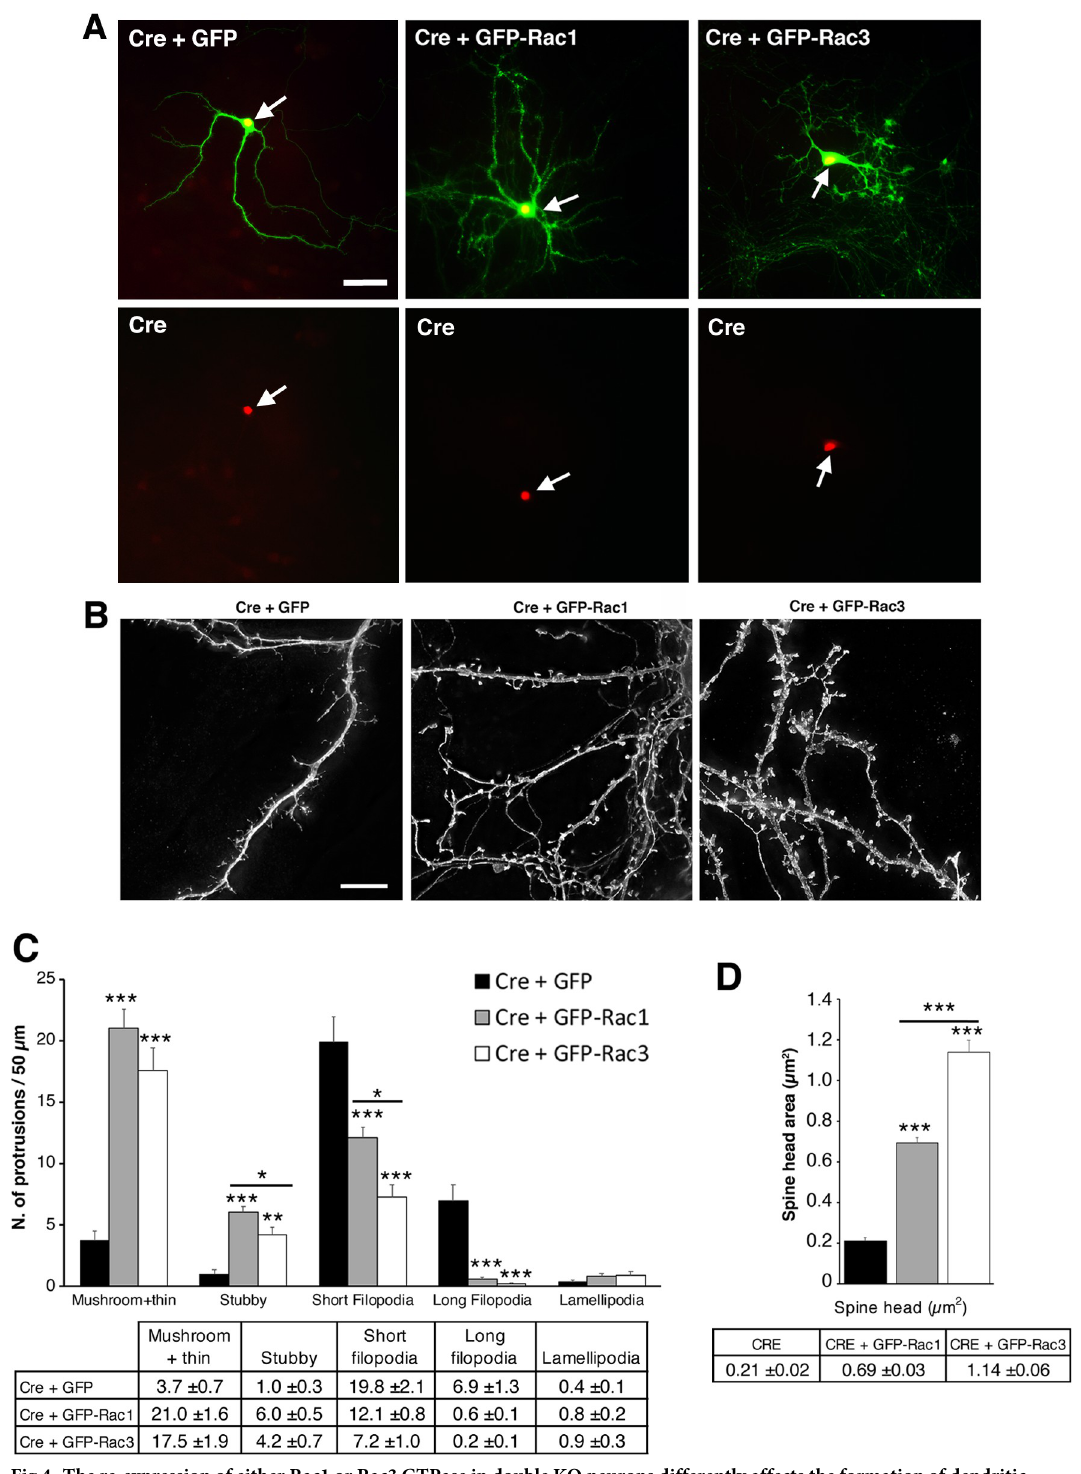
Fig 4. The re-expression of either Rac1 or Rac3 GTPase in double KO neurons differently affects the formation of dendritic spines. ( A ) Morphology of DIV14 Rac3 KO ( Rac1F/F//Rac3KO ) hippocampal neurons cotransfected at DIV4 with the plasmid for the Cre recombinase together with the plasmid for either GFP, GFP-Rac1, or GFP-Rac3. Neurons were fixed at DIV14 and stained with anti-GFP Ab (green) and anti-Cre Ab (red, nuclear). Images at the bottom show the same neurons from the top row, to highlight the nuclear localization of the Cre recombinase. Bar, 50 μ m. ( B ) High magnifications of double KO hippocampal neurons ( Rac1F/F//